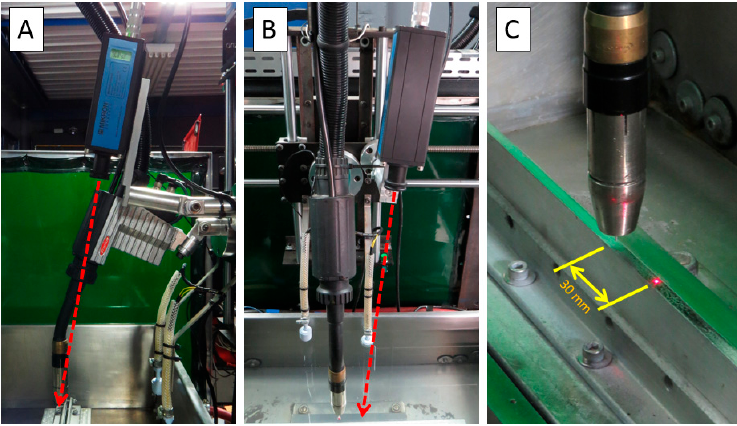
Figure 2. IR pyrometer arrangement for in-processing-measuring of the interpass temperature: ( A ) front view; ( B ) lateral view; ( C ) measuring spot target. ( A ) front view; ( B ) lateral view; ( C ) measuring spot Table 3. IR pyrometer specification.